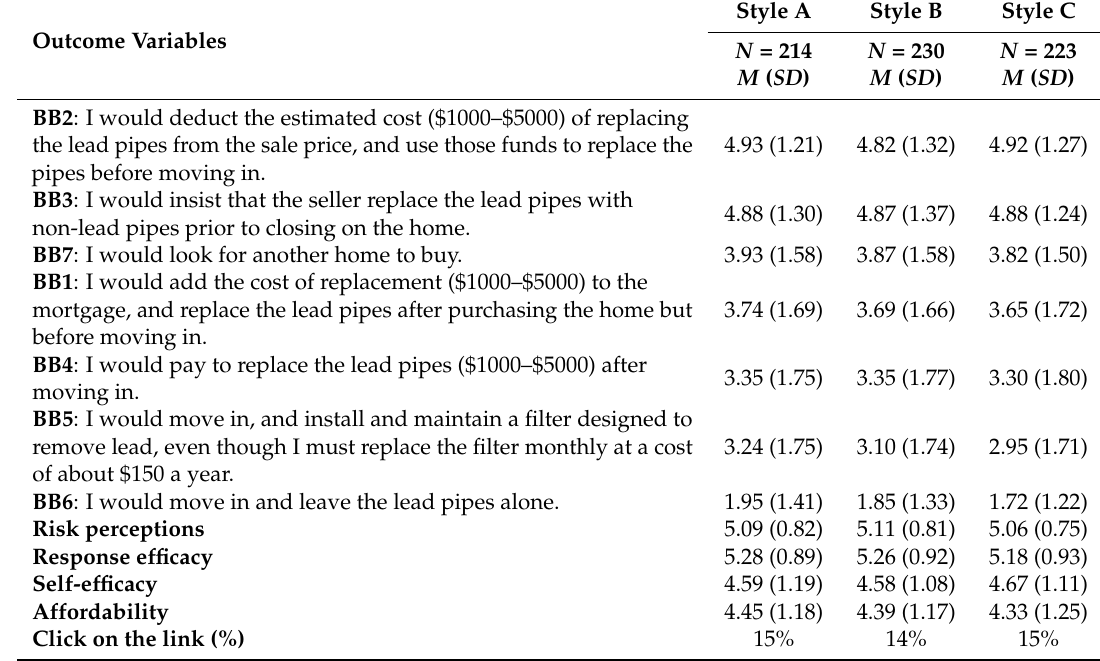
Table note: Unless otherwise indicated, these variables were measured on a 1–6 scale. Conditions with the same letter in the same row are statistically different at p < 0.05 (One-way ANOVA results with Bonferroni corrections; the result for “click on the link” was based on a logistic regression). M: mean; SD: standard